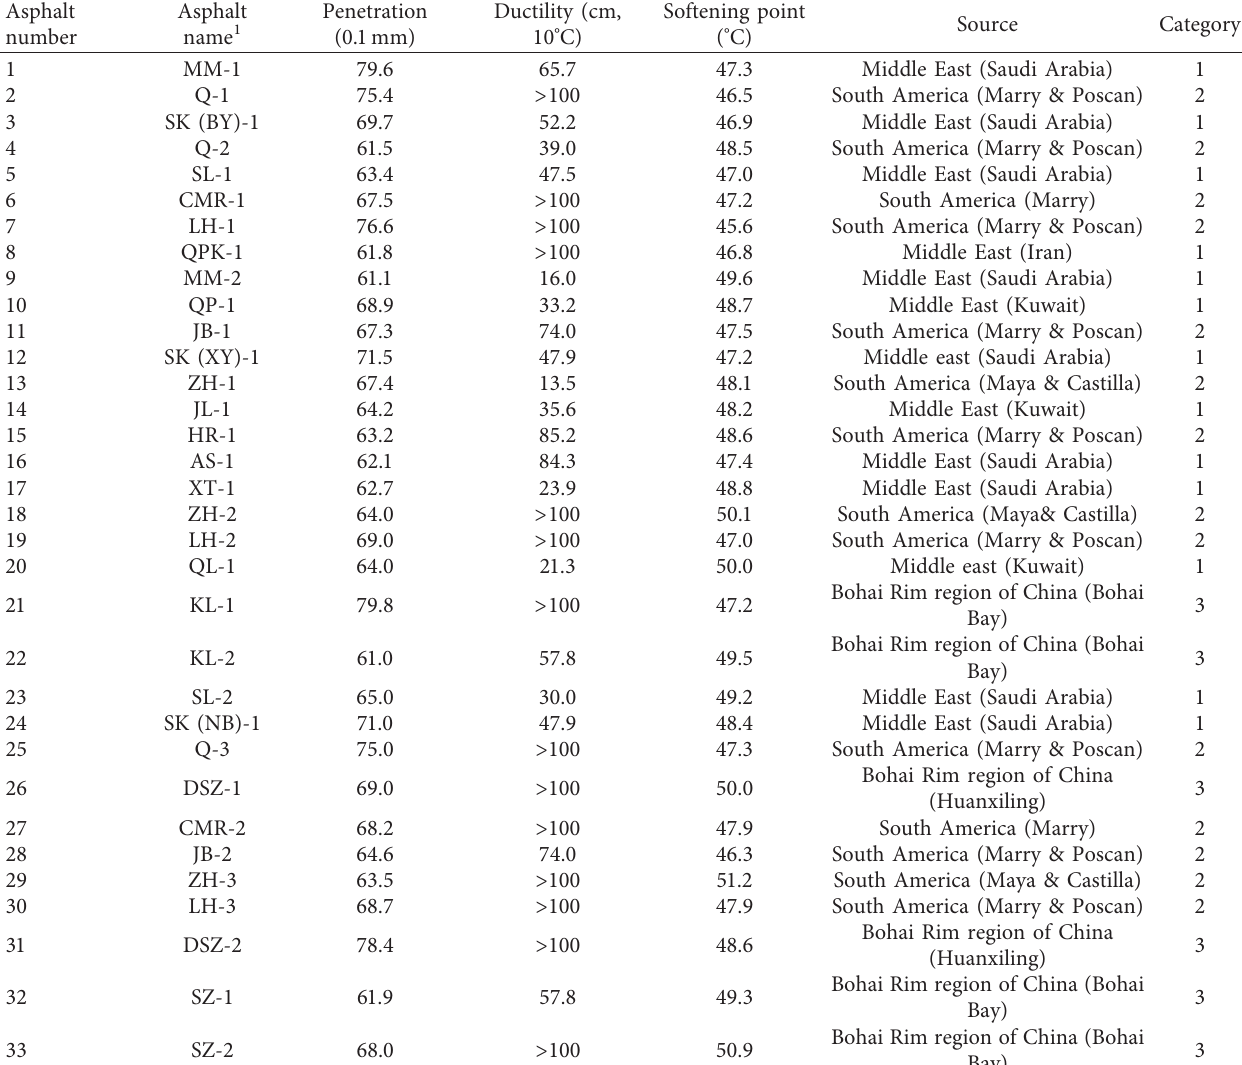
Table 1: Basic properties and crude oil source of